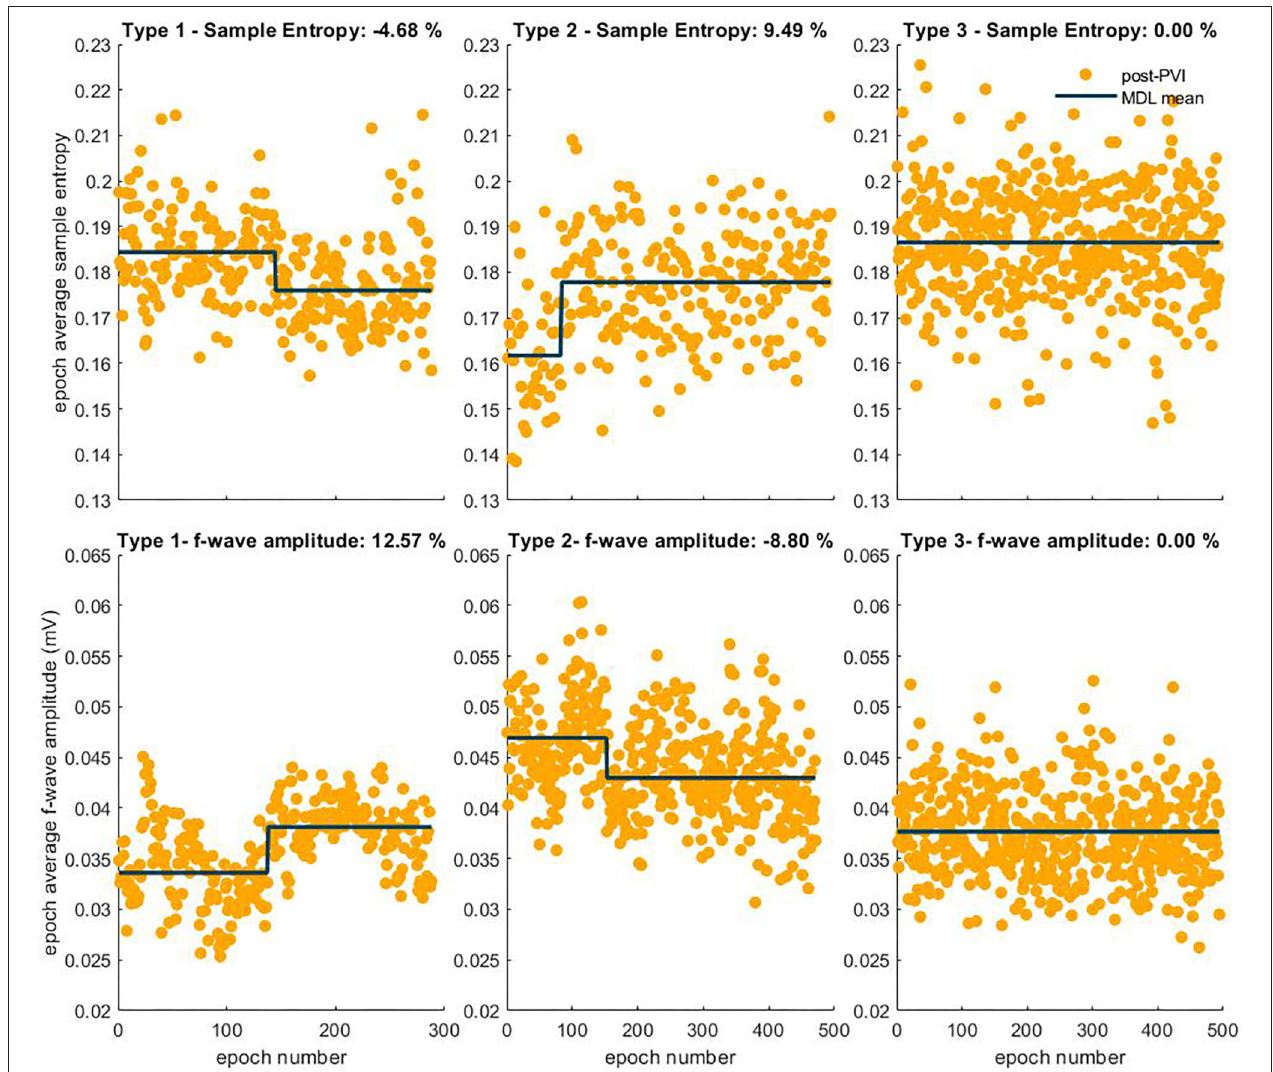
FIGURE 7 | Three types of AF organization. The observed relative percent change is indicated in the title of each example. The first column shows examples of Type 1, increasing AF organization, indicated by a negative SampEn transition in the first row and a positive FWA transition in the second row. The second column shows examples of Type 2, decreasing AF organization, indicated by a positive transition in the SampEn sequence, and negative transition in the FWA epoch sequence. Finally, the third column shows examples of Type 3, no change in AF organization, indicated by no transitions in either